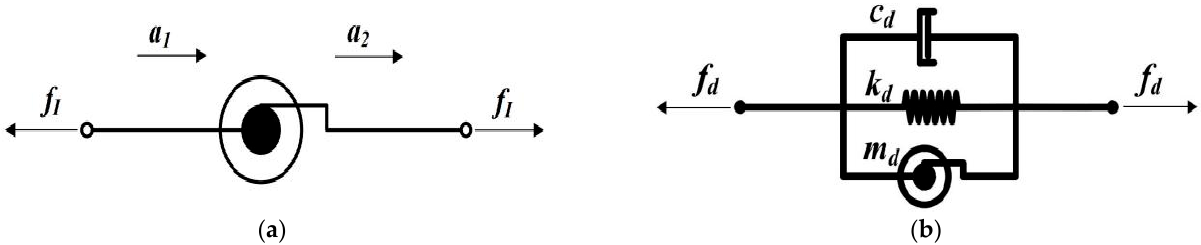
Figure 1. Mechanical model: ( a ) an inerter element; ( b ) IIS.